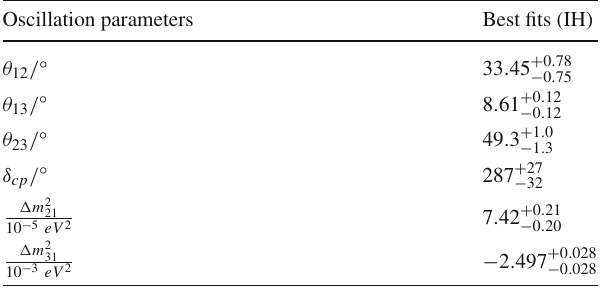
Table 2 Best fits and 1 σ ranges for the oscillation parameters, from [2] Oscillation